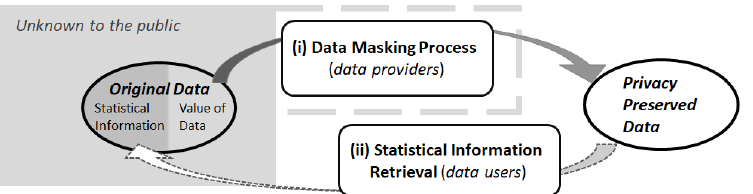
Figure 1. Overview of the data privacy process. The grey area is unavailable to the public for privacy purposes. Information regarding the data masking process performed by data providers can be made partially available to the